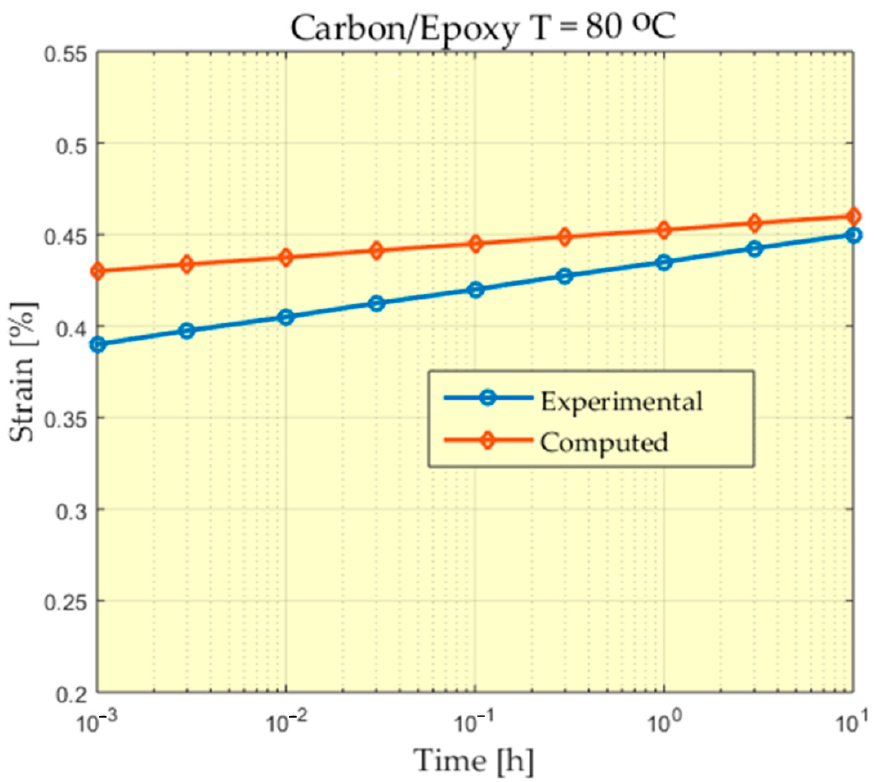
Figure 7. Comparison between experimental and theoretical prediction of creep strain for Car- bon/PEEK subjected to 47 MPa at 80 °C.